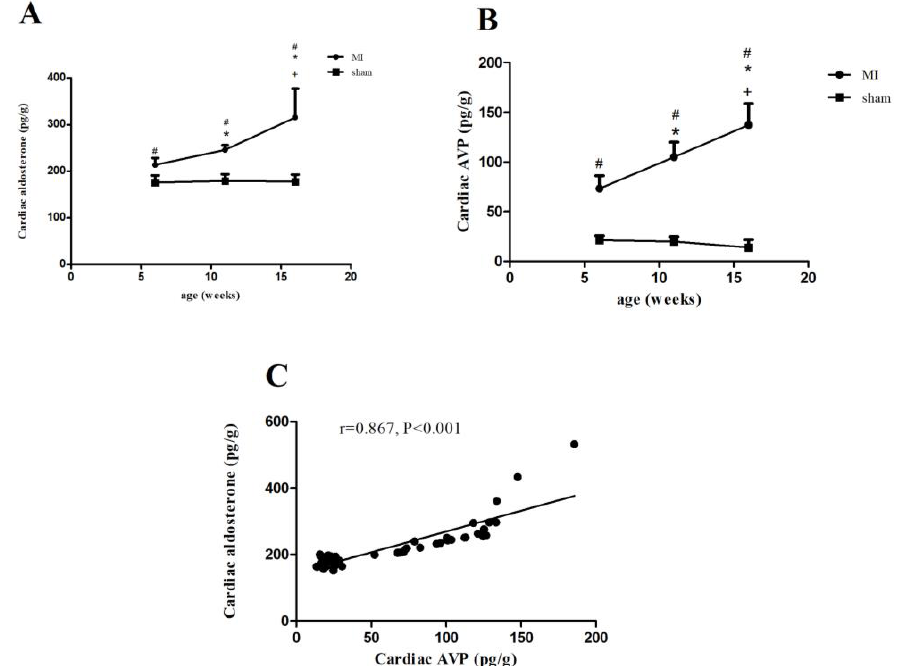
Figure 2. Concentrations of aldosterone and AVP in left ventricular non-infarcted region of rats. ( A ) Representative graph of aldosterone concentration. ( B ) Representative graph of AVP concentra- tion. AVP, arginine vasopressin. ( C ) Correlation analysis between aldosterone and AVP. # p < 0.05 vs. sham-operated rats of the same age; * p < 0.05 vs. 6w MI; + p < 0.05 vs. 11w MI.